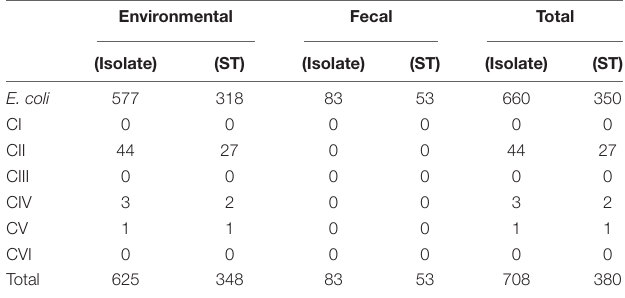
TABLE 2 | Number of STs contributed by E. coli and cryptic clades.